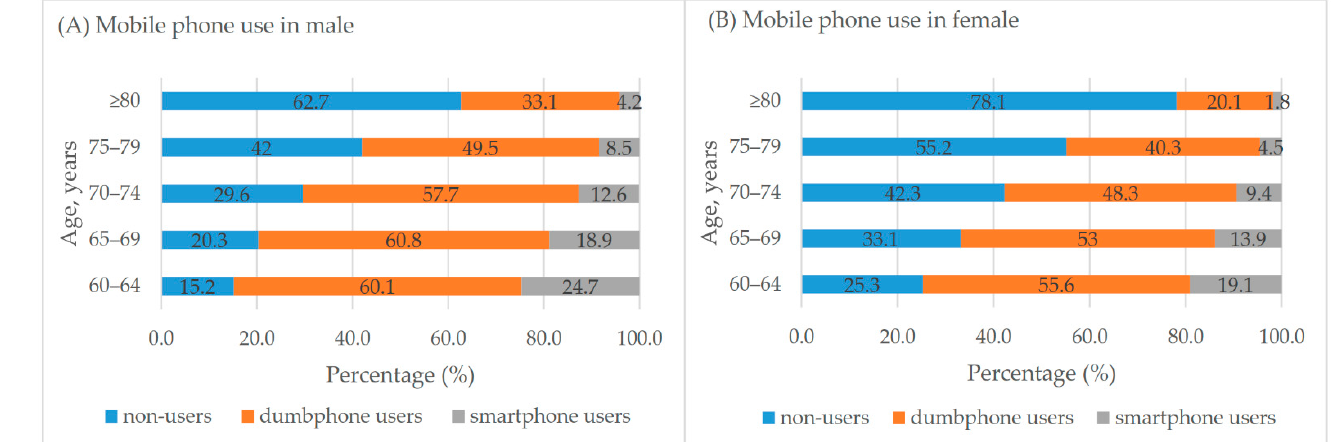
smartphones due to the reasons of “don’t know how to use it” (85.9%), “feels unneces-